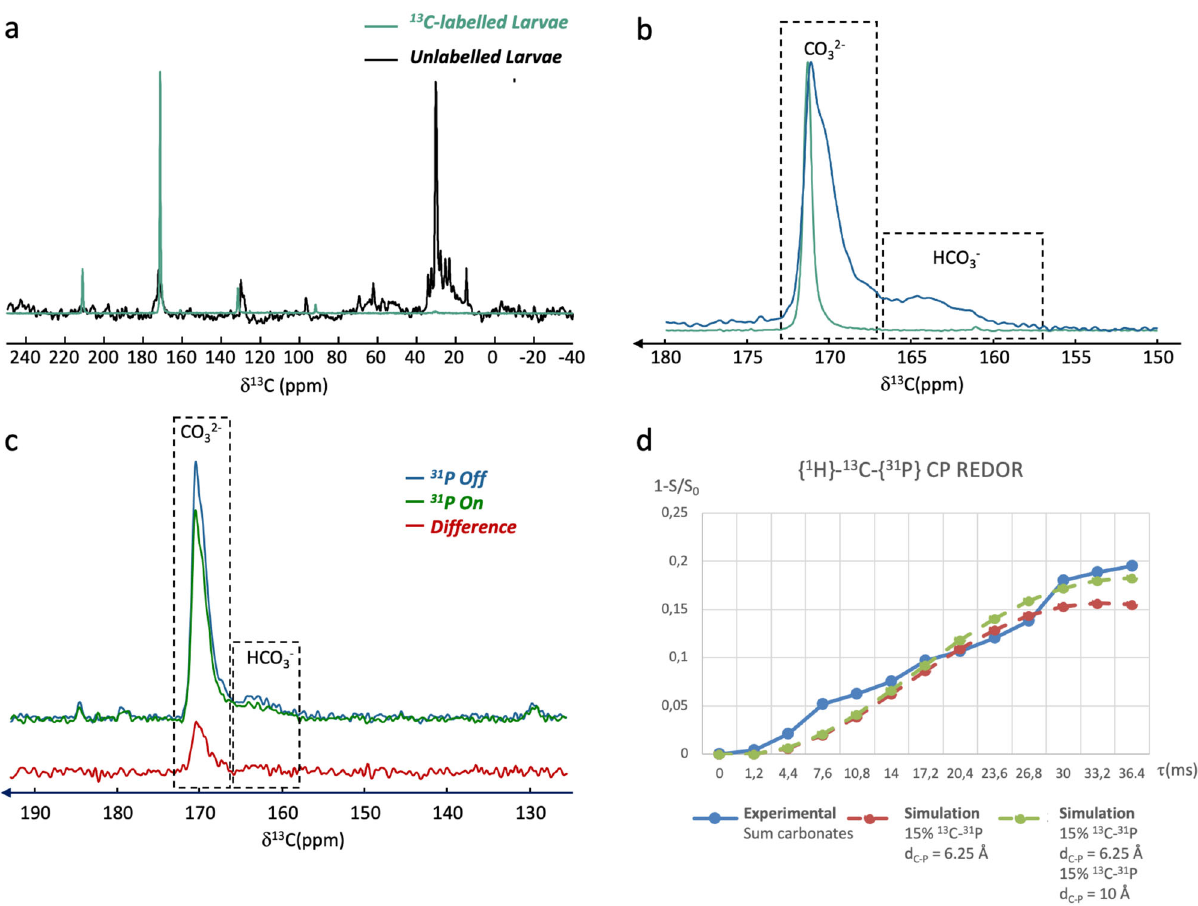
Fig. 2 Localization of the ACP-like phase in abalone larval shell. a 13 C DE MAS NMR spectra of unlabelled (black, NS = 620) and 13 C-labelled (green, NS = 104) of fresh H. tuberculata larvae (72hpf). b Close-up on the carbonate region: 13 C DE MAS NMR (green) and 1 H- 13 C CP MAS NMR spectrum (blue, t = 750 µ s). c { 1 H}- 13 C-{ 31 P} CP REDOR experiment of 13 C-labelled fresh 72 hpf larvae. Recoupling time = 36 ms. d { 1 H}- 13 C-{ 31 P} CP REDOR curve and CP numerical simulation (see text for details; error bars